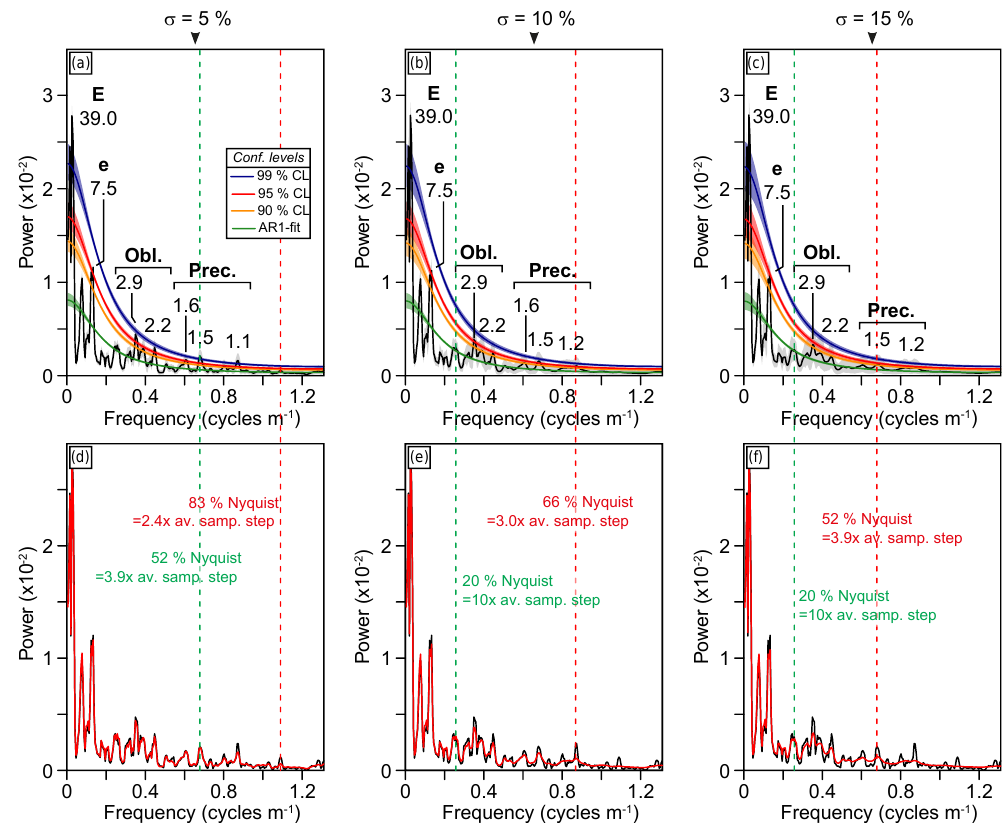
Figure 10. Effect of the gamma-law randomisation of the sample distances on the 2 π -MTM spectrum of the La Thure series. Panels a to c : 2 π -MTM spectra with a level of stratigraphic uncertainty fixed to 5, 10 and 15% of the average sample distance of the series. The grey area represents the interval covering 95% of the simulations. The average confidence levels are reported on the spectra with their respective areas covering 95% of the simulations. Main significant periods are indicated in metres with, in bold, their corresponding orbital cycles. E: 405kyr eccentricity; e: 100kyr eccentricity. Panels d to f : superposition of the 2 π -MTM spectra before randomisation (in black) and the average spectrum after the 1000 simulations (in red). The red dashed lines indicate the lowest frequency above which the spectrum is completely smoothed, so that no other frequency can be identified. The green dashed lines represent the highest frequency below which the spectrum of the series before randomisation appears practically identical to the spectrum after